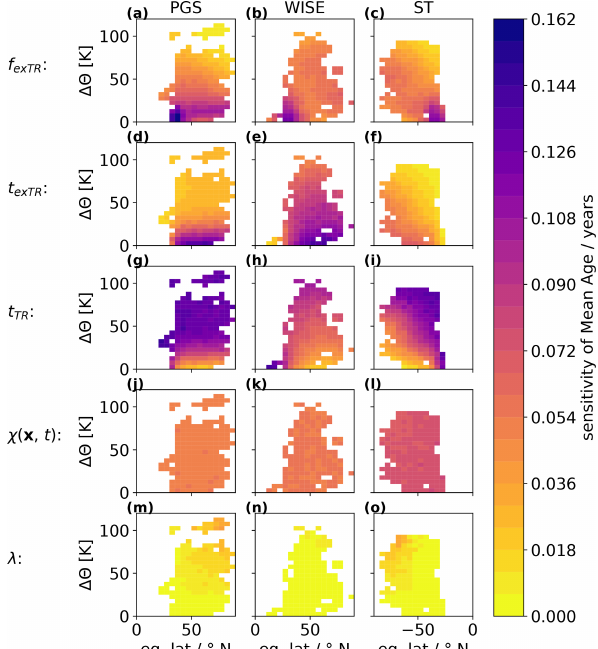
Figure 6. As Fig. 5, but each uncertain parameter is considered in- dependently, assuming the others to be accurate. Uncertain param- eters: exTR origin fraction ( f exTR , a–c ), time shift to exTR entry region ( t exTR , d–f ), time shift to TR entry region ( t TR , g–i ), SF 6 mixing ratio measurement uncertainty ( χ ( x ), j–l ) and the ratio of moments ( λ , m–o